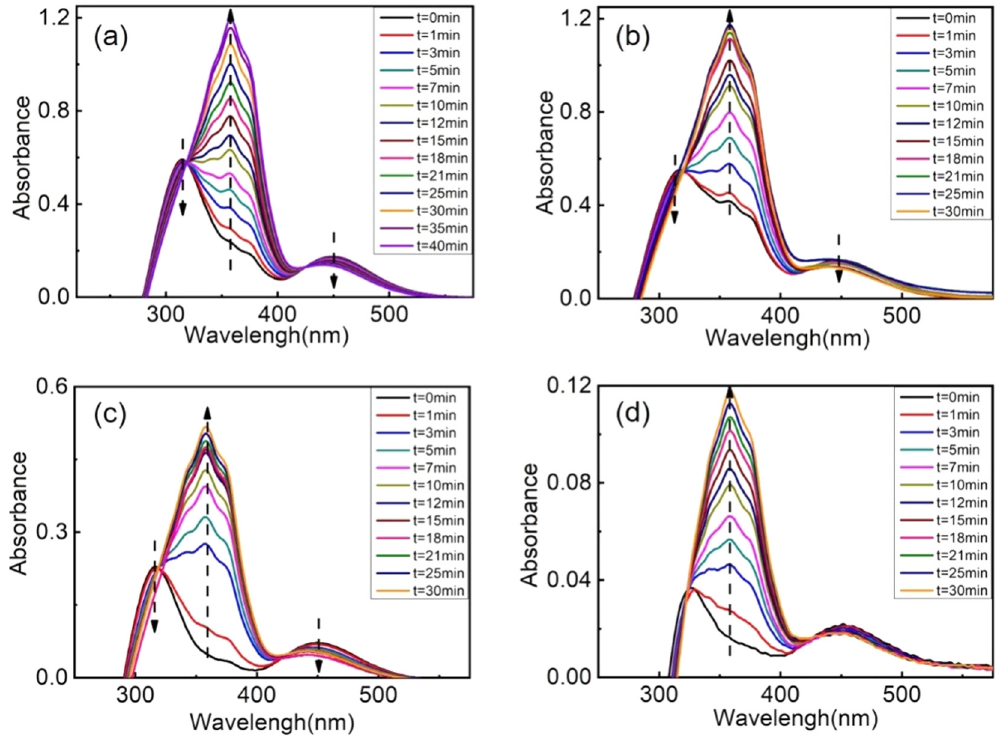
Figure 6: The UV absorption of liquid crystalline polymer: ( a ) LCP, ( b ) LCP - POSS - 1, ( c ) LCP - POSS - 2, and ( d ) LCP - POSS - 3 at di ff erent times with visible light.